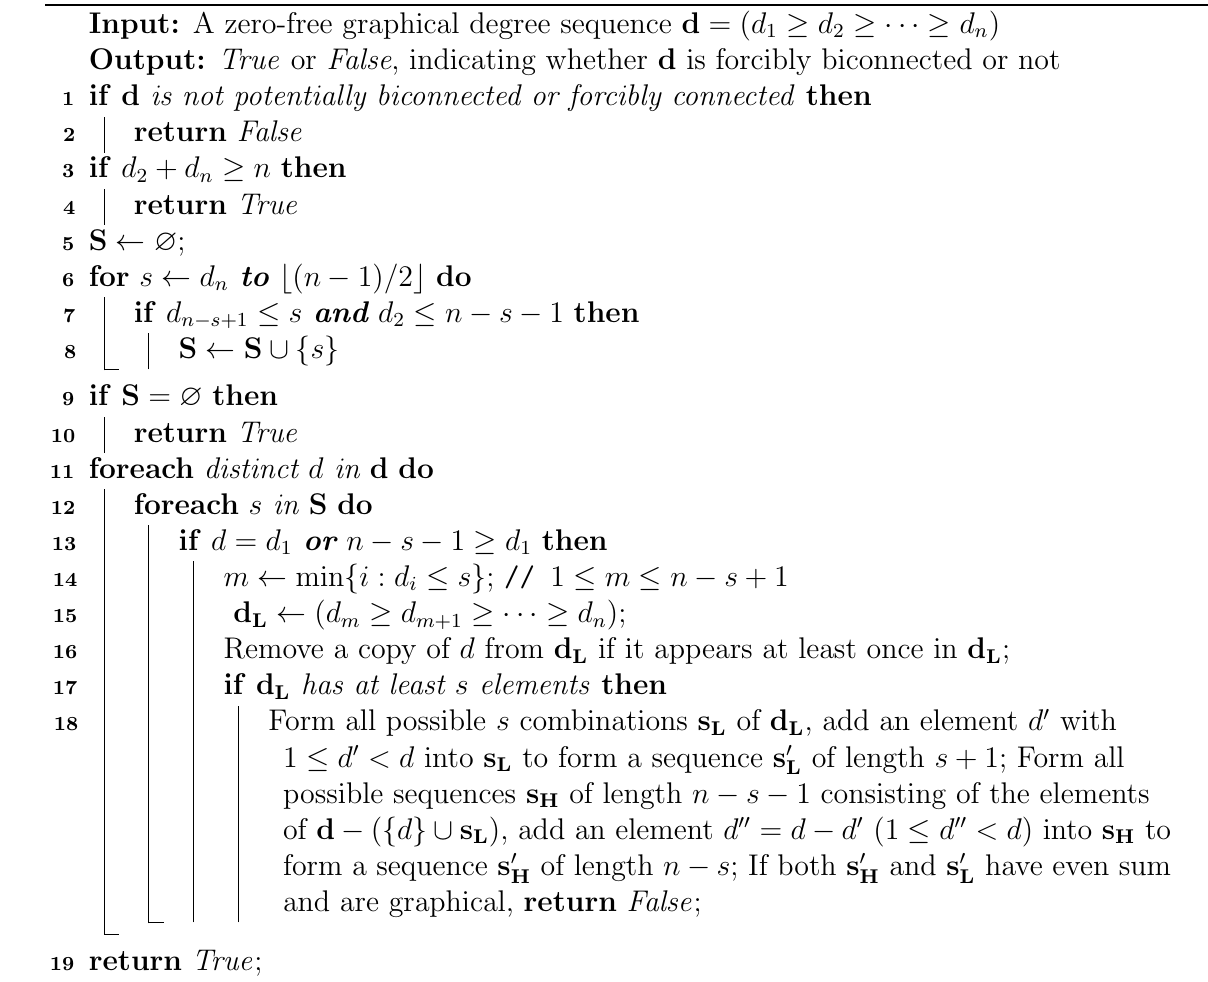
Algorithm 2: improved version pseudo-code to test whether a graphical degree sequence is forcibly